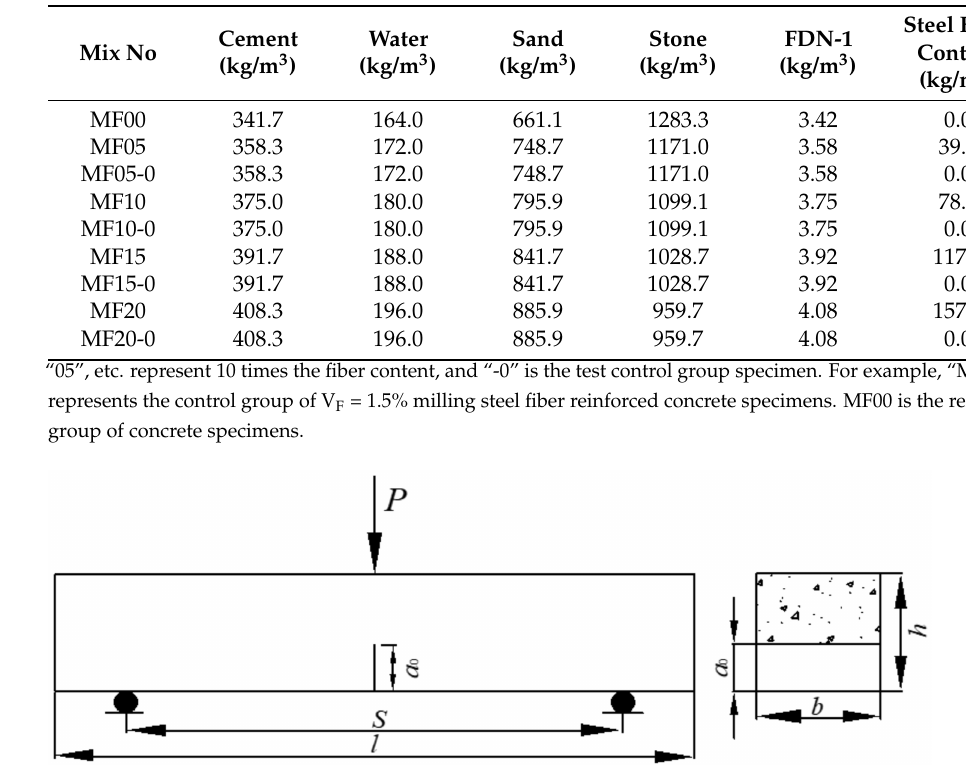
Table 1. Mix proportion of steel fiber reinforced concrete (SFRC) and ordinary concrete (OC).